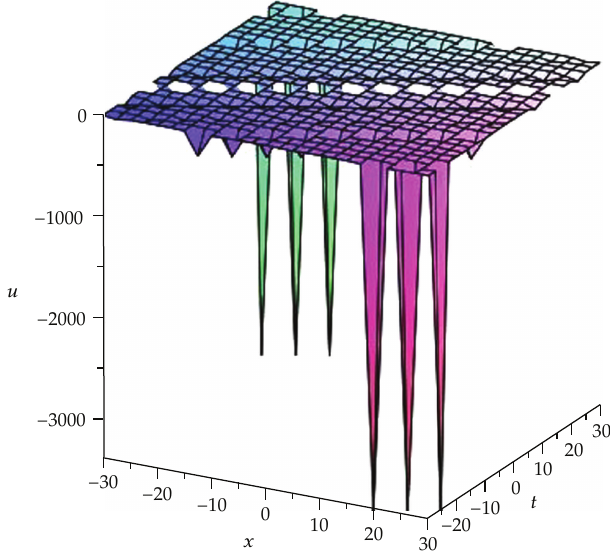
Figure 6: The solution u 5 of GSWW equation with k (cid:7) 0 . 1, c (cid:7) 2, α (cid:7) 3, β (cid:7)